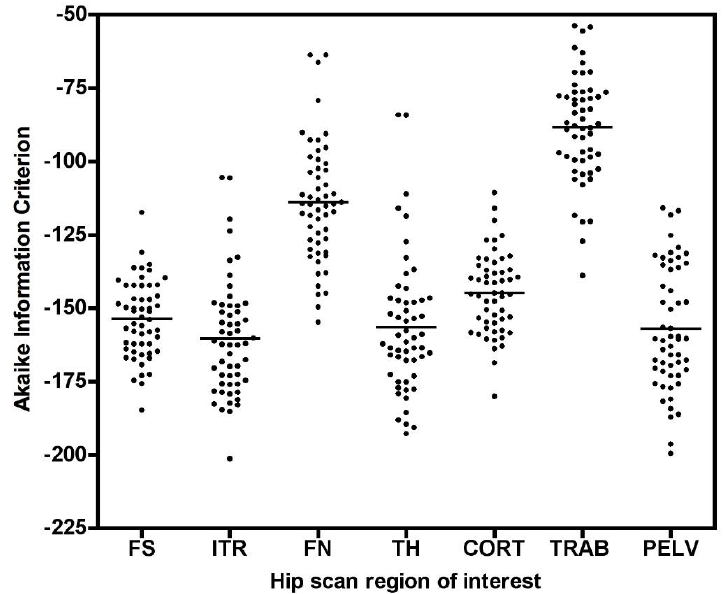
Figure A2. Akaike information criterion (AIC) results for the 0–60min PET scan Hawkins model curve fits for all volumes of interest (VOI) (FS: femoral shaft VOI; ITR: intertrochanteric VOI; FN: femoral neck VOI; TH: total hip VOI; CORT: cortical bone VOI; TRAB: trabecular bone VOI; PELV: pelvis VOI). Data at each VOI are for both the baseline and 12-week follow-up scans.